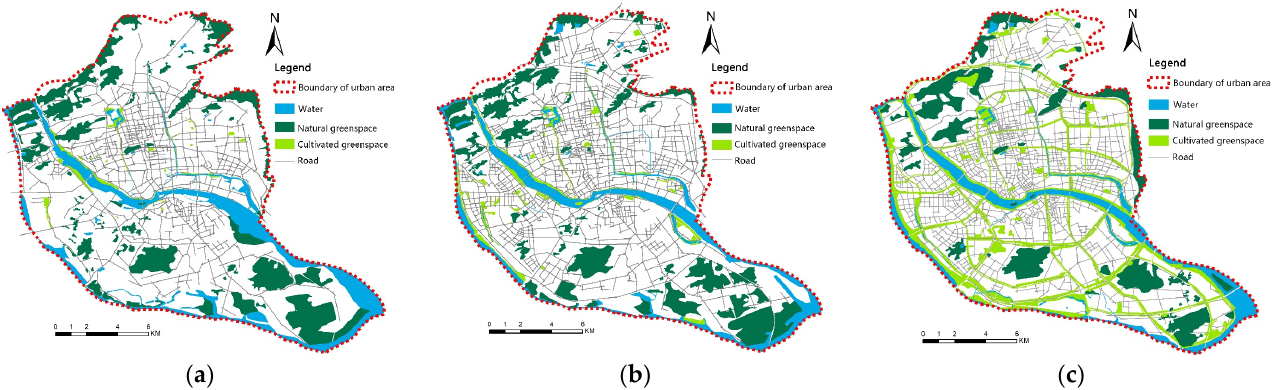
Figure 8. Green space of Fuzhou: ( a ) green space in 2000; ( b ) green space in 2010; ( c ) green space in 2021.